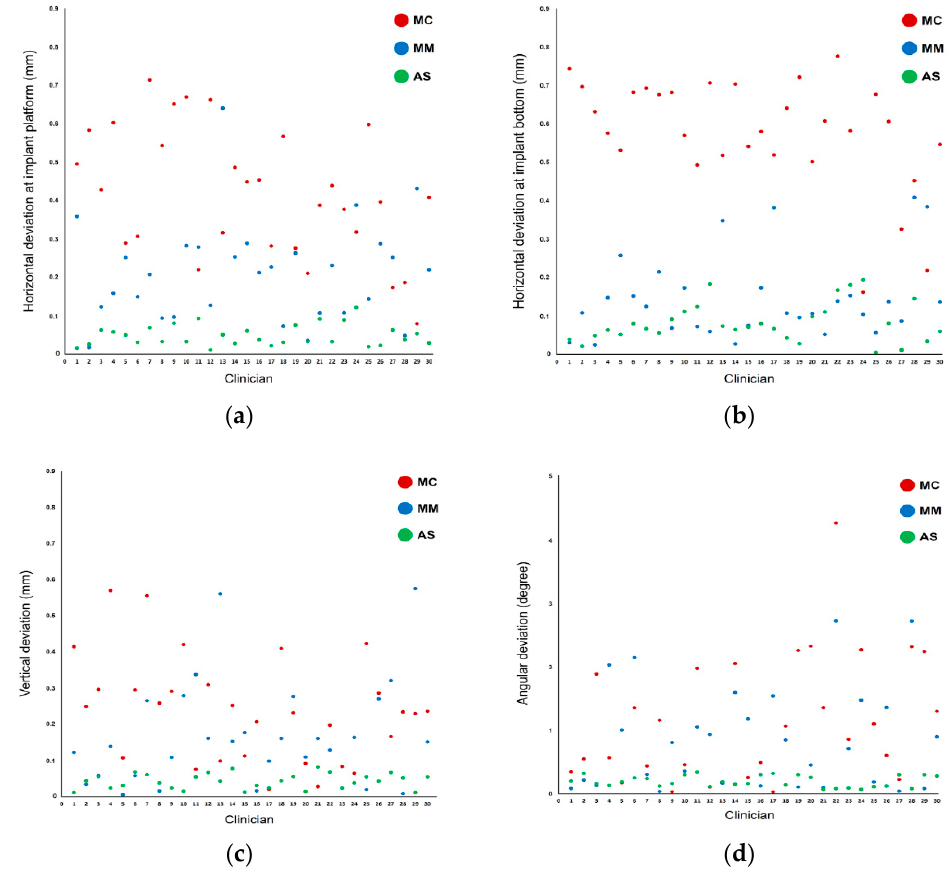
Table 1. Values of geometric discrepancy between the estimated and actual positions of the implant using different detection methods.